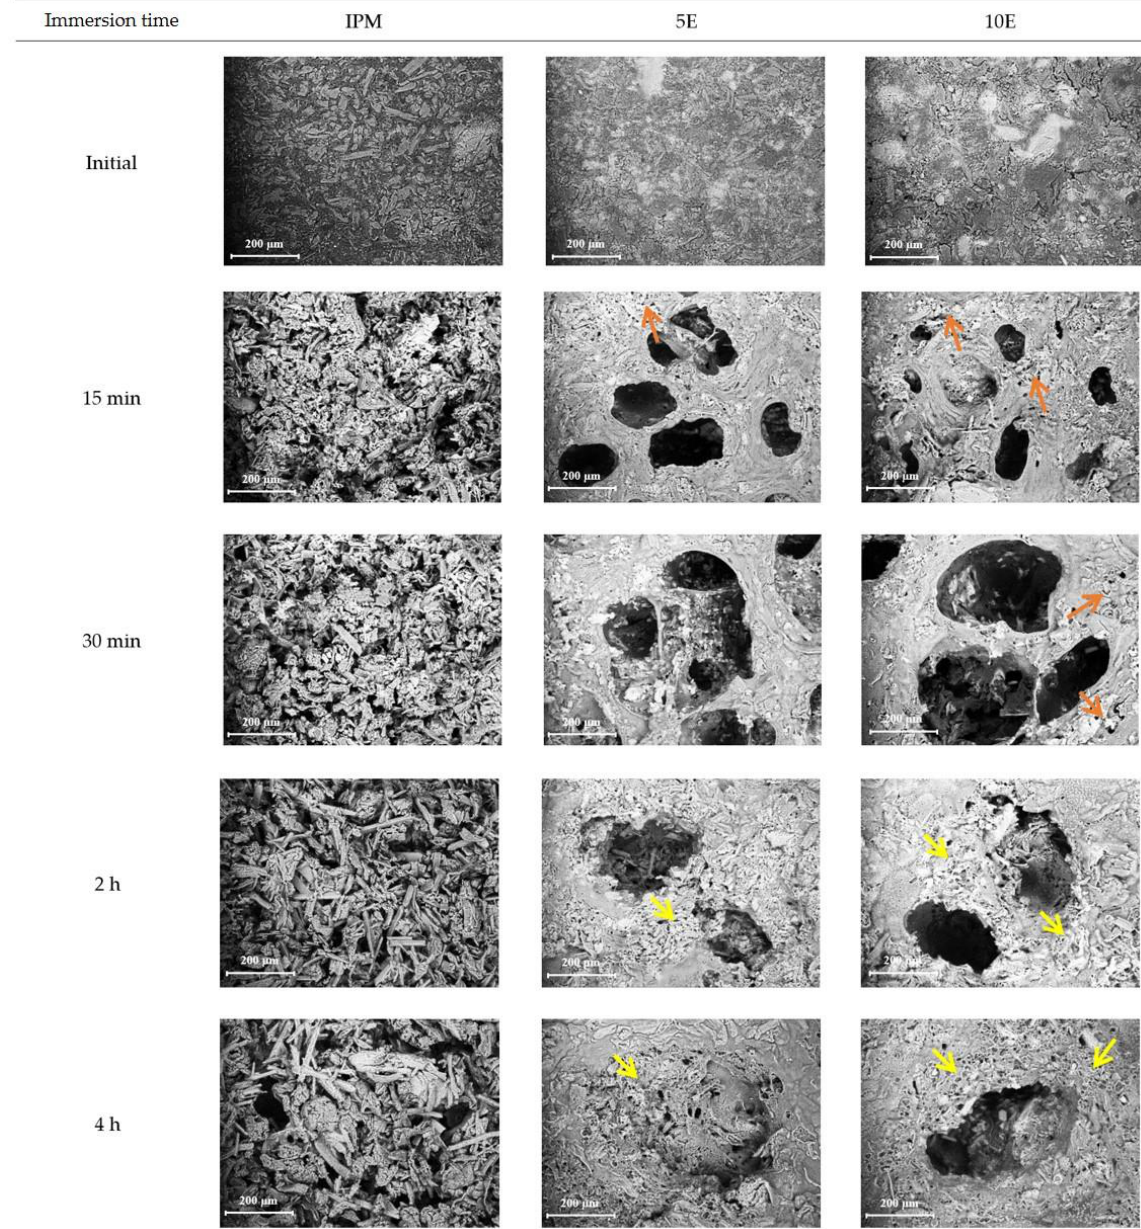
Figure 6. SEM micrographs of IBU-P407 effervescent matrix tablets in pH-changed media at various immersion times (magnification: 250×).